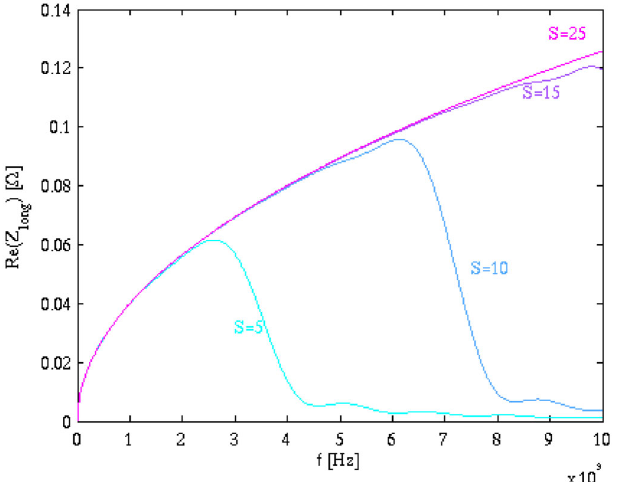
FIG. 4. Convergence of P modes in mode matching: detailed convergence for the first mode after cutoff. With P ¼ 20 convergence is well below